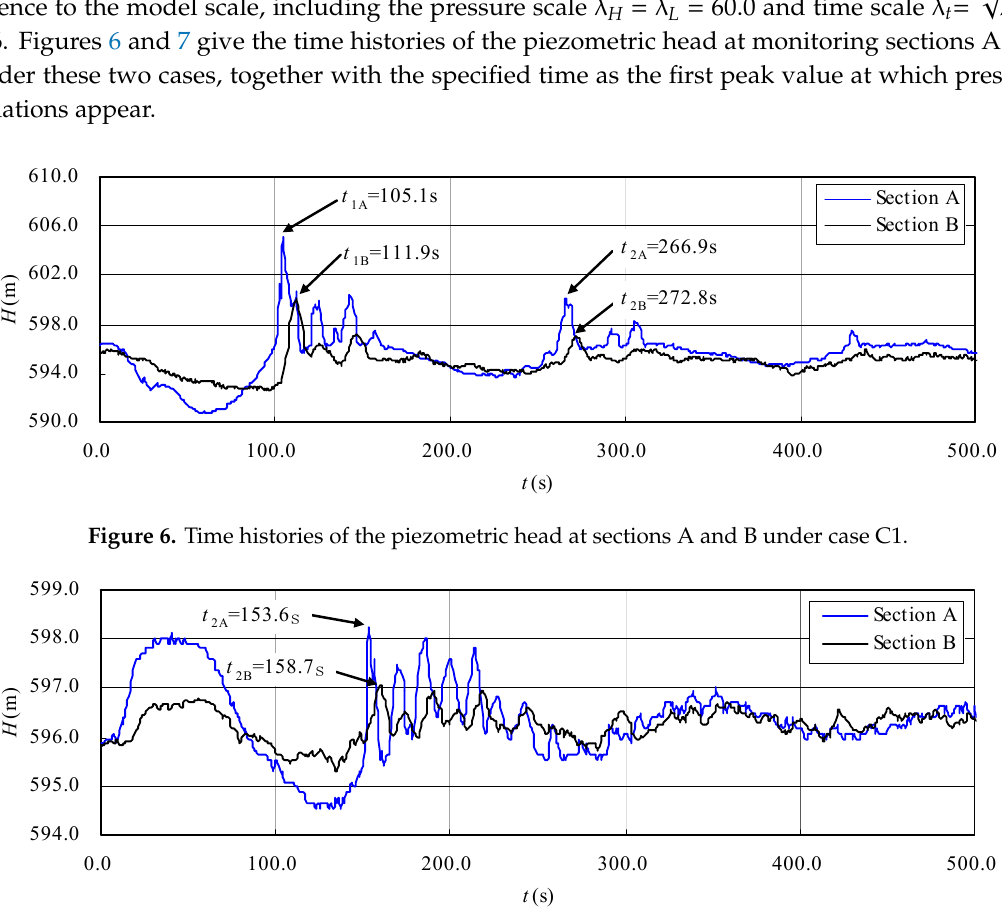
Figure 5. Layout of the tail system.